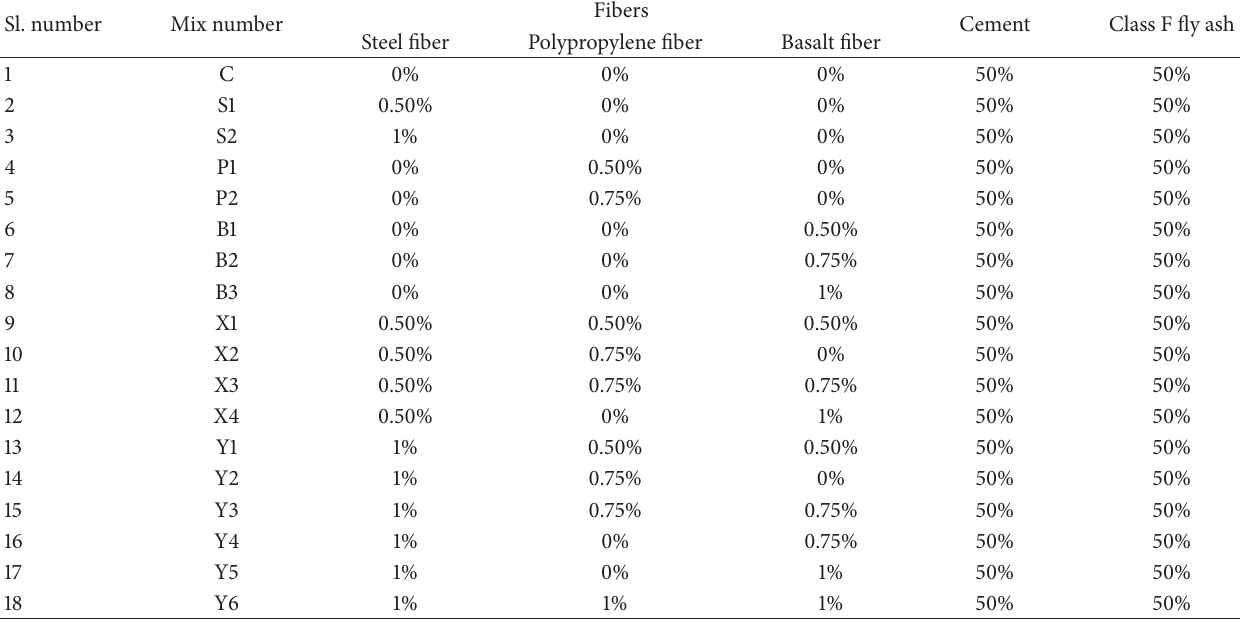
Table 1: Specimen nomenclature.